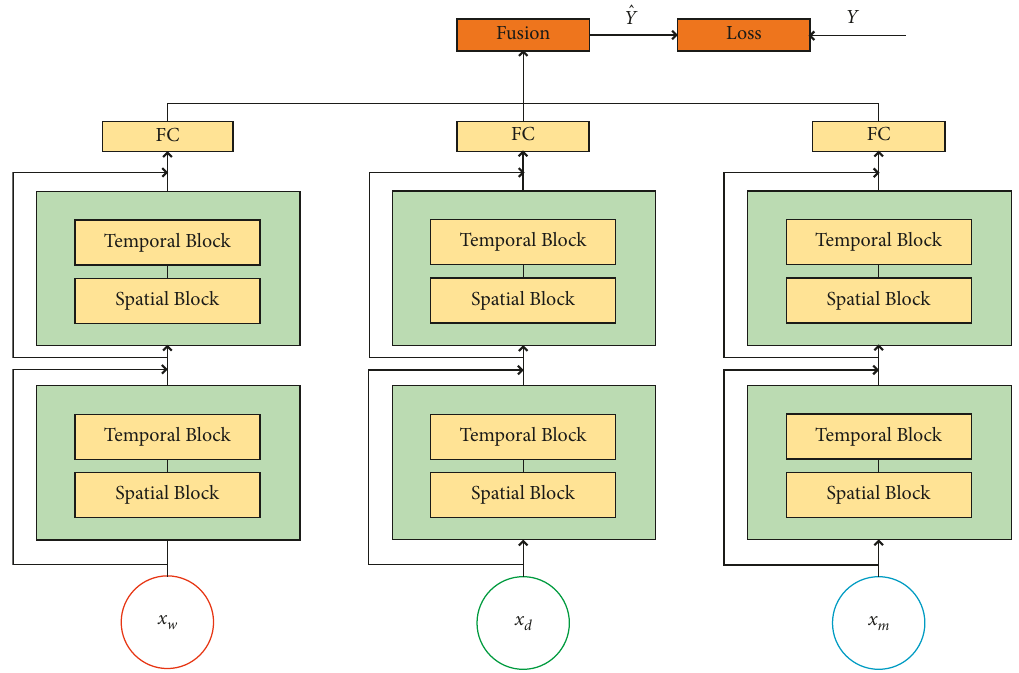
Figure 1: The framework of the proposed